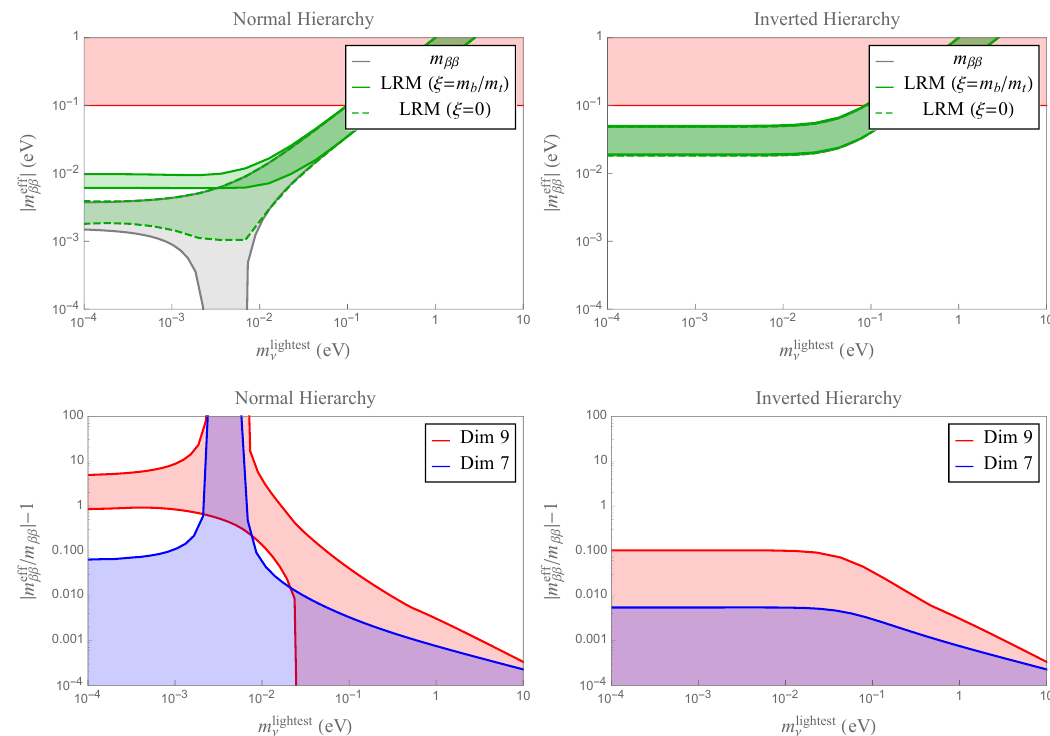
Figure 3 . The upper-left and -right panels show m e(cid:11) the normal and inverted hierarchy, respectively. The gray bands depict the contribution from m (cid:12)(cid:12) alone, while the (dashed) green bands show the full mLRSM contribution for (cid:24) = m b =m t ( (cid:24) = 0) with the choices of model parameters in eq. (6.20). The current experimental limit on 136 Xe, derived using the NMEs of ref. [33] and g NN and -right panels show the combination respectively. Here we take (cid:24) = m b =m t and show the results when turning on only the dim-5 and dim-7 (dim-5 and dim-9) terms in m e(cid:11)